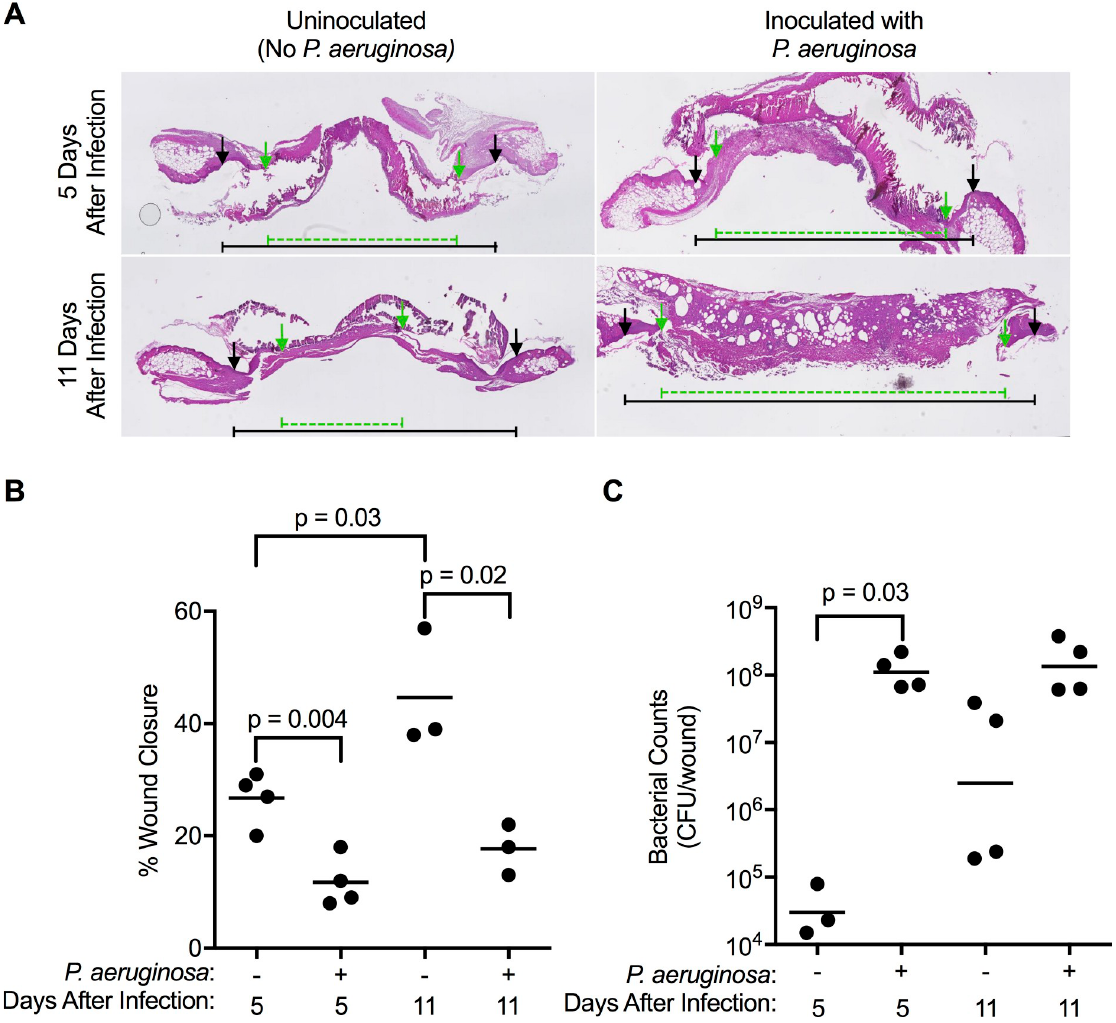
Fig 1. Wound infections initiated with P . aeruginosa liquid cultures delay wound healing. A. H&E staining of excised wounds show original wound edges (black arrows) and the extent of epithelial migration after 5 or 11 days of healing (green arrows). B. The extent of wound closure (healing) was delayed in wounds challenged with P . aeruginosa . C. Total CFU recovered from wounds shows P . aeruginosa - challenged wounds contained high bacterial densities, and unchallenged wounds harbored low densities of bacteria (likely due to spontaneous infection Staphlococcus sp . as previously observed [52]). For A and B, each point represents data from an individual mouse. Significance determined by Mann-Whitney